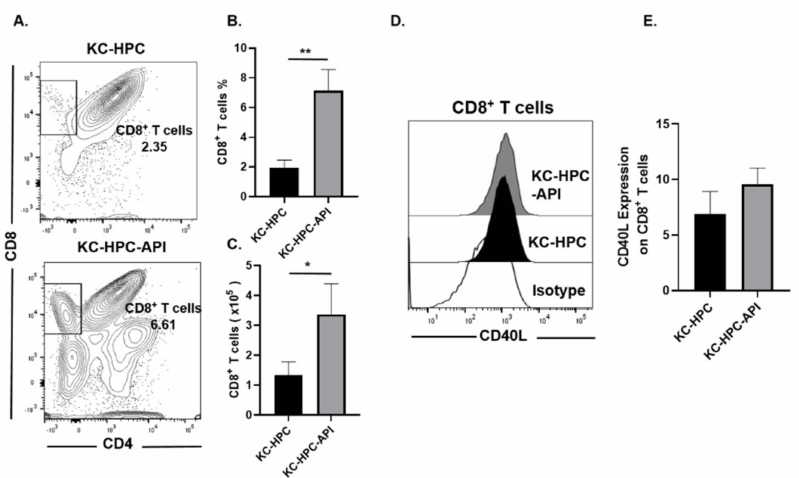
Figure 10. API treatment of KC-HPC mice increased CD8 + T cell infiltration into the tumor. ( A , B ) Flow cytometric analysis and ( C ) absolute cell number of CD8 + T cells (CD3 + CD8 + CD4 − ) and its expression of ( D , E ) CD40L in the tumors of vehicle-treated KC-HPC mice and API treated KC-HPC mice. Data are presented as the mean ± S.D. of KC-HPC ( n = 4), KC-HPC-API ( n = 4) mice. * p < 0.05; ** p < 0.01 (by two-tailed t